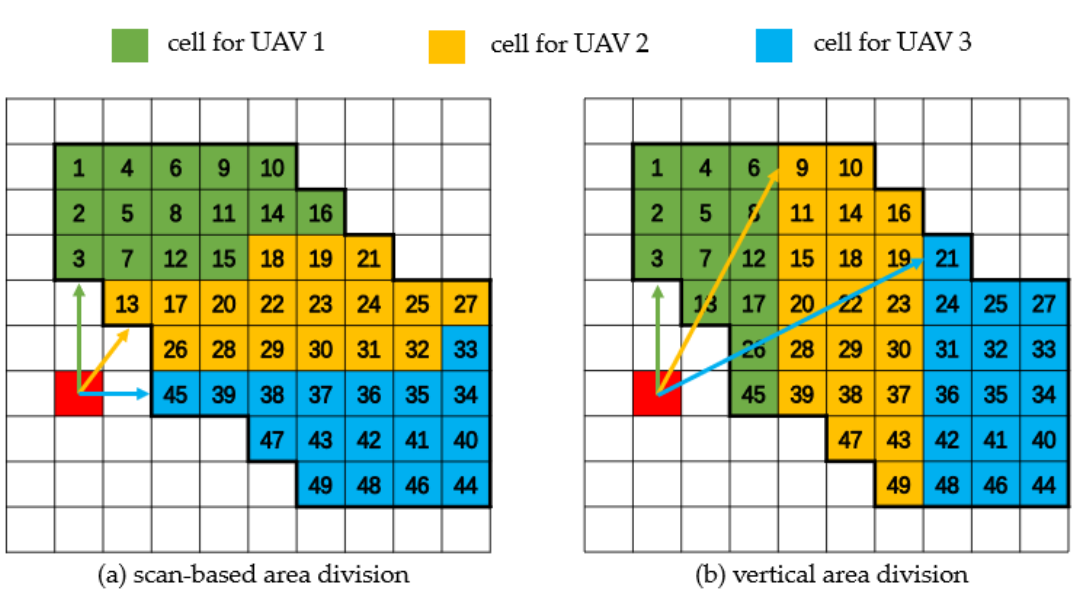
Figure 4. Results of scan-based area division and vertical area division.